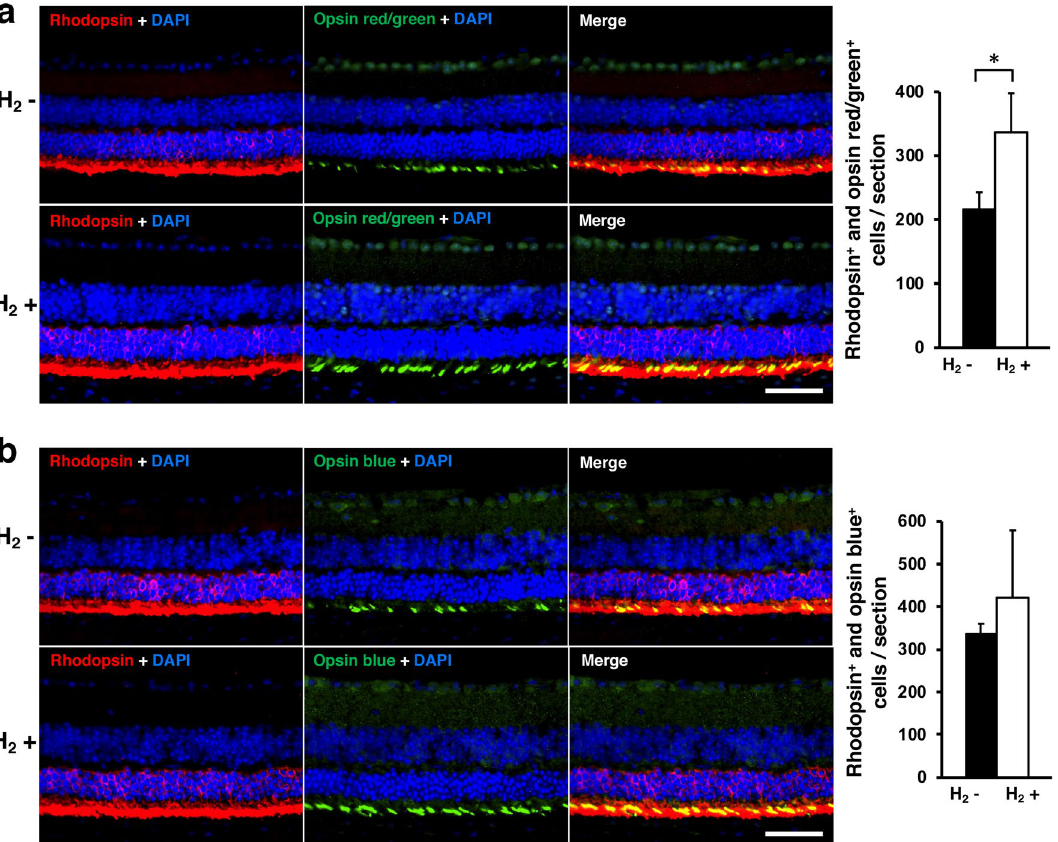
Figure 5. Immunohistochemical analysis of rhodopsin and opsin. ( a ) Immunohistofluorescence co-staining for rhodopsin (red) and opsin red/green (green) is shown in representative retinal specimens with/without H 2 water. Double-positive cells (yellow) were counted for eye cups in one slide. The number of double- positive cells was significantly greater in the control group (n = 4) than in the H 2 group (n = 4; p < 0.05). ( b ) Immunohistofluorescence co-staining (yellow) for rhodopsin (red) and opsin blue (green) is shown in representative retinal specimens with/without H 2 water. No significant difference was found (p = 0.35). Scale bar 50 μm. Bars depict mean ± standard deviation